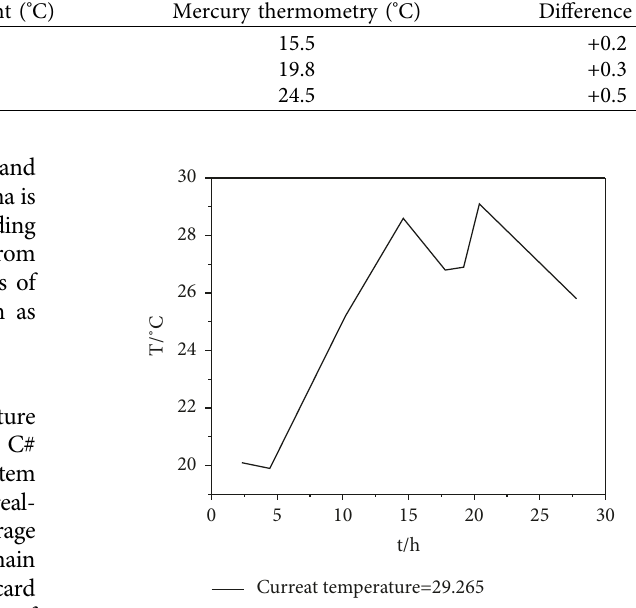
Figure 4: 24h temperature of phase A